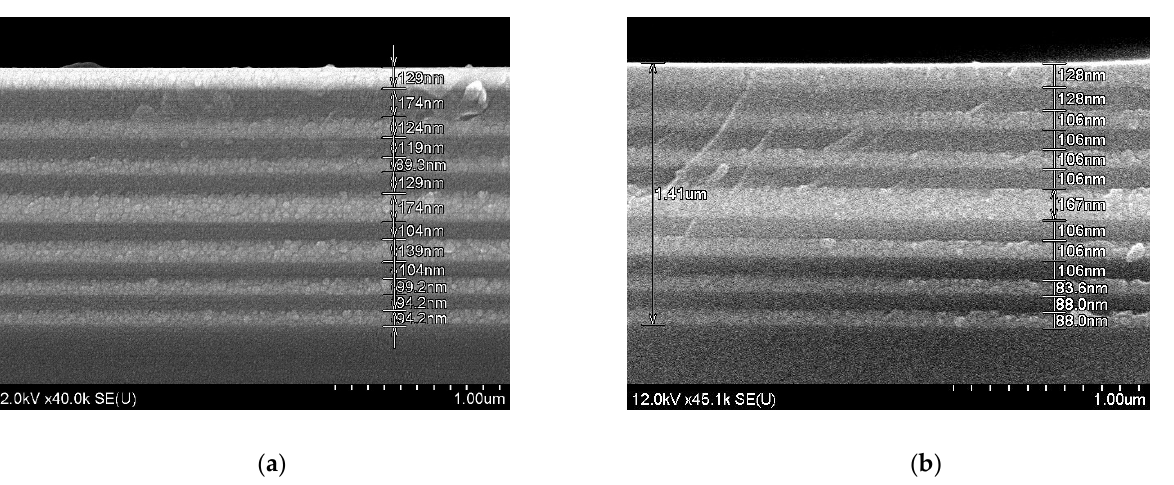
Figure 7. SEM images of the BaTiO 3 /SiO 2 microcavity (sample F) after heat treatment at 450 °C ( a ) and 600 °C ( b ).